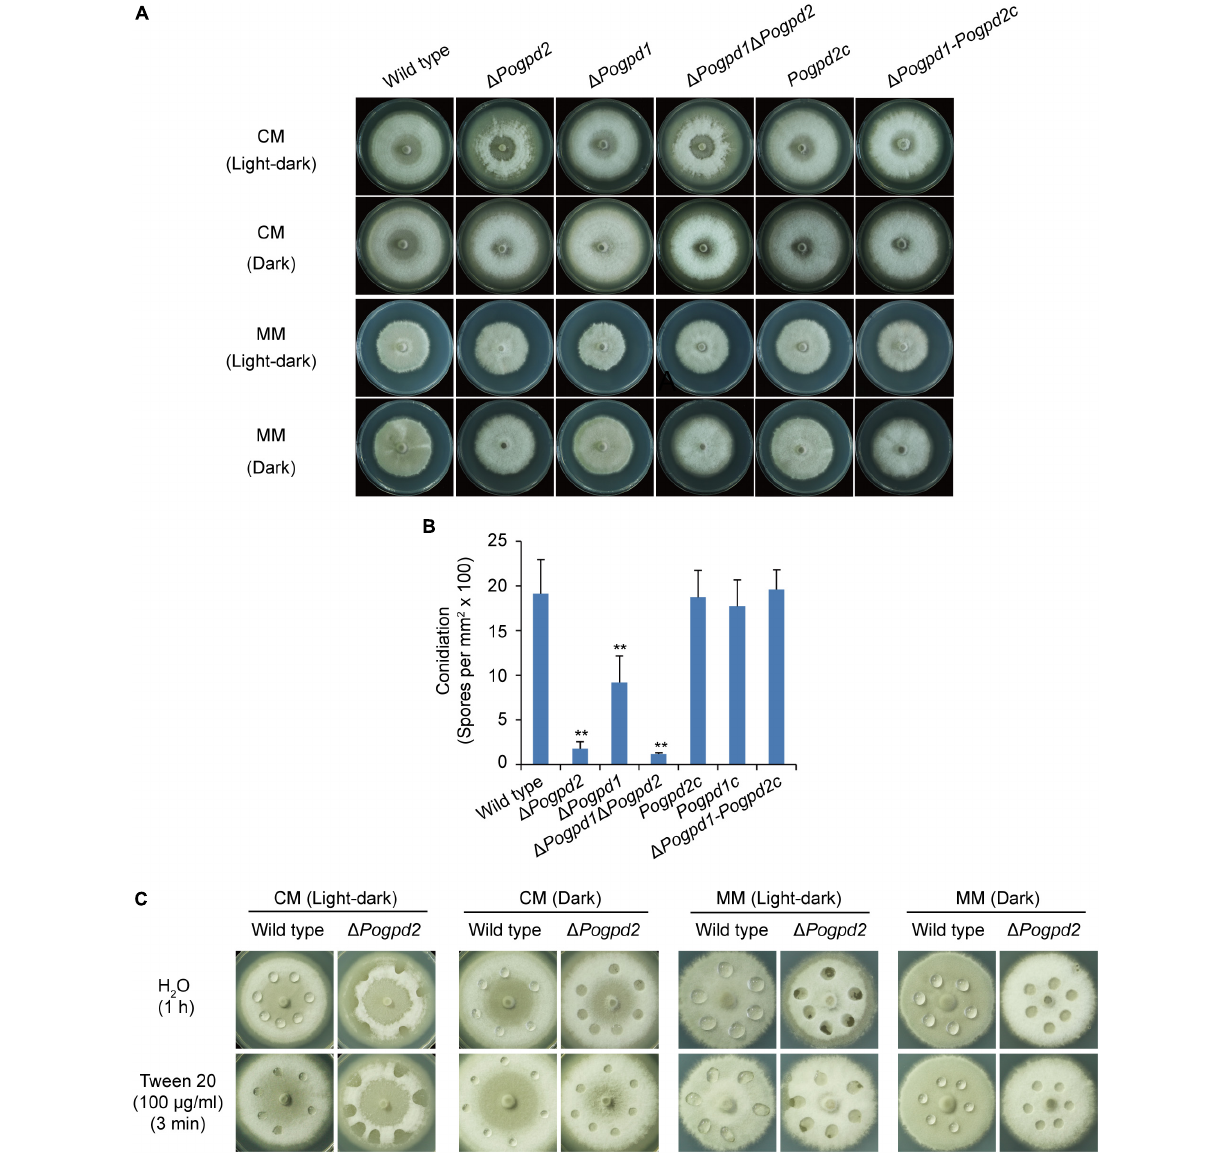
FIGURE 5 | Roles of glycerol-3-phosphate dehydrogenases in aerial hyphal differentiation and conidiation. (A) Colonies of the wild type, (cid:49) Pogpd1 , (cid:49) Pogpd2 , and (cid:49) Pogpd1 (cid:49) Pogpd2 , and the complementation strains Pogpd2c and (cid:49) Pogpd1 - Pogpd2c , grown on CM and MM media under a light–dark cycle or a continuous dark condition for 8 days. (B) Conidiation in P. oryzae strains (the wild type, (cid:49) Pogpd1 , (cid:49) Pogpd2 , and (cid:49) Pogpd1 (cid:49) Pogpd2 ) cultured on CM medium under a light–dark cycle for 8 days. (C) Surface hydrophobicity assay for the aerial mycelia of the wild type and (cid:49) Pogpd2 . Significant difference compared with the wild type as estimated by Tukey’s HSD test: ∗∗ P <